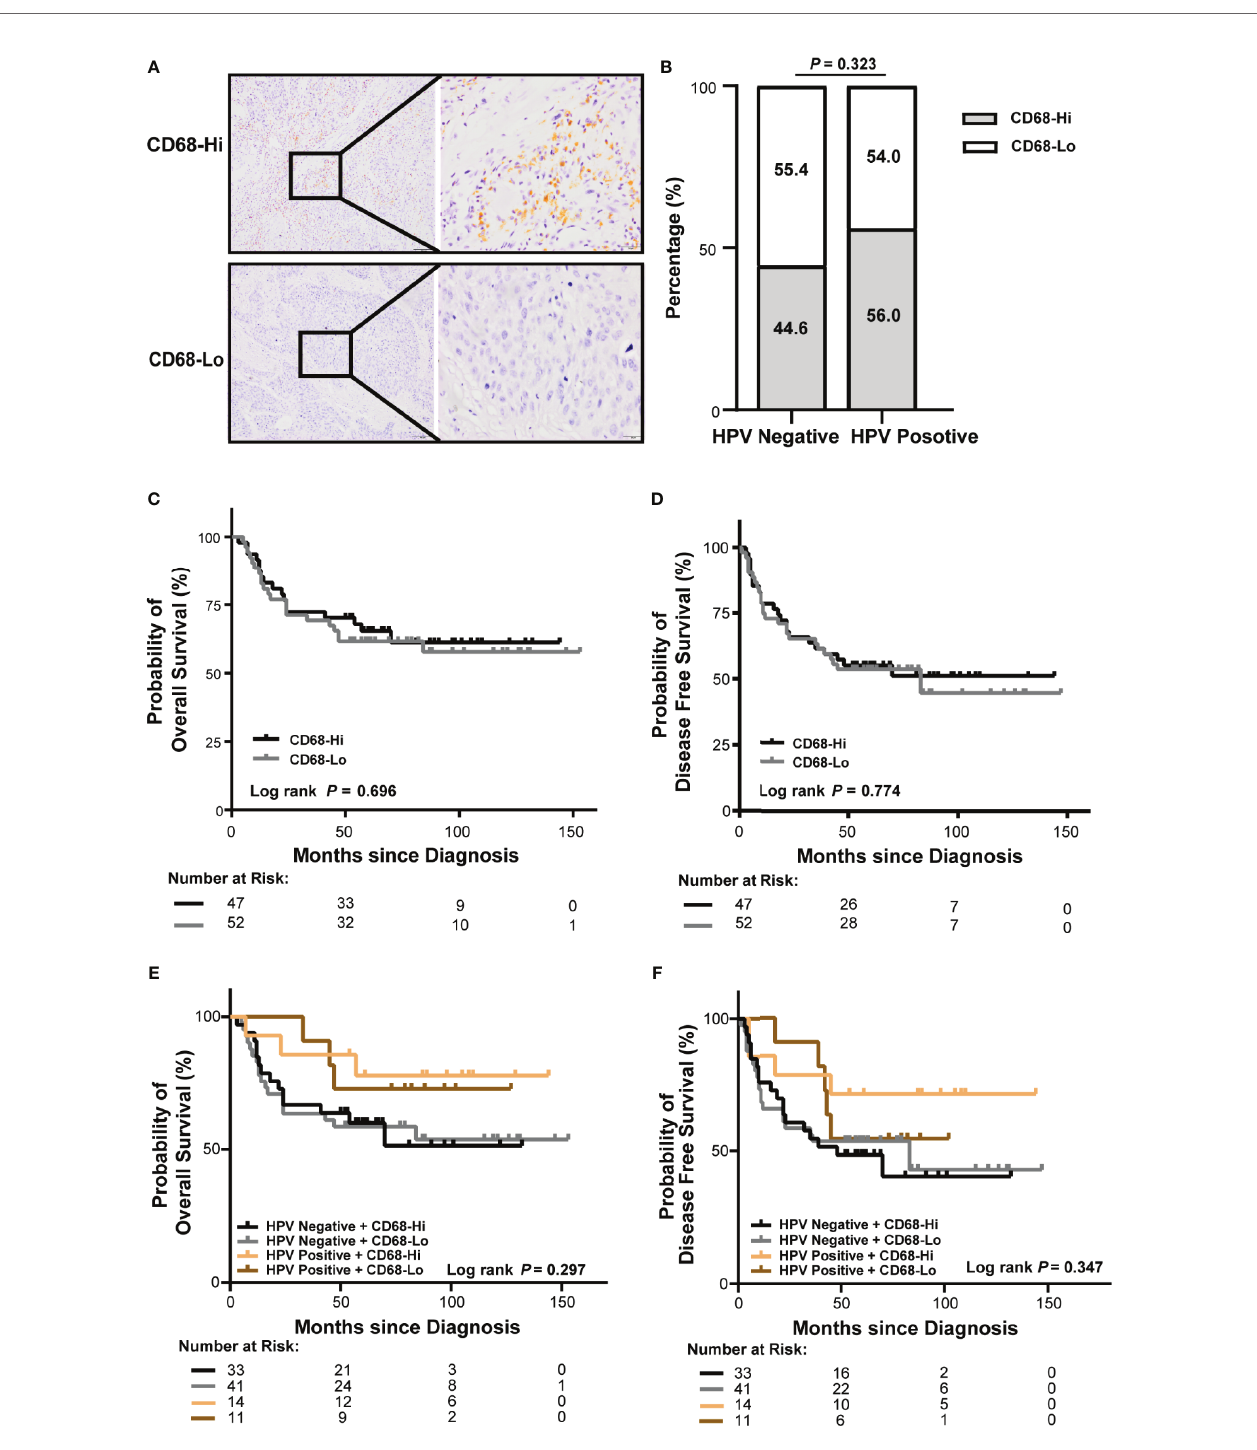
FIGURE 3 | Association of CD68 + macrophage in fi ltration and HPV status with survival of OSCC patients in our cohort. (A) Representative immunohistochemical images of high or low level of CD68 + macrophages in OSCC (left: 100×, right: 400×). (B) Proportion of high or low level of CD68 + macrophages in patients with HPV negative and HPV positive OSCC. (C, D) Kaplan-Meier curves exhibit overall survival (C) and disease-free survival (D) in high or low level of CD68 + macrophage in fi ltrated OSCC patients. (E, F) Kaplan-Meier curves exhibit overall survival (E) and disease-free survival (F) in high or low level of CD68 + macrophage in fi ltrated OSCC patients with HPV negative and HPV positive status. Log-rank test and/or pair wised comparison was used for signi fi cance. CD68-Hi, CD68-High; CD68-Lo, CD68-Low; RT,